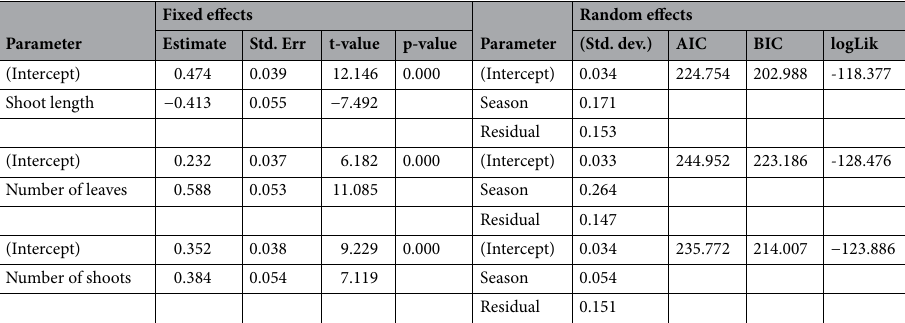
Table 4. The results of generalized mixed model (restricted maximum likelihood method) of B. pendula seedlings biometric traits. The research sites (Zn–Pb D, Control L) was treated as a fixed variable while vegetative seasons (2012, 2013) as a random